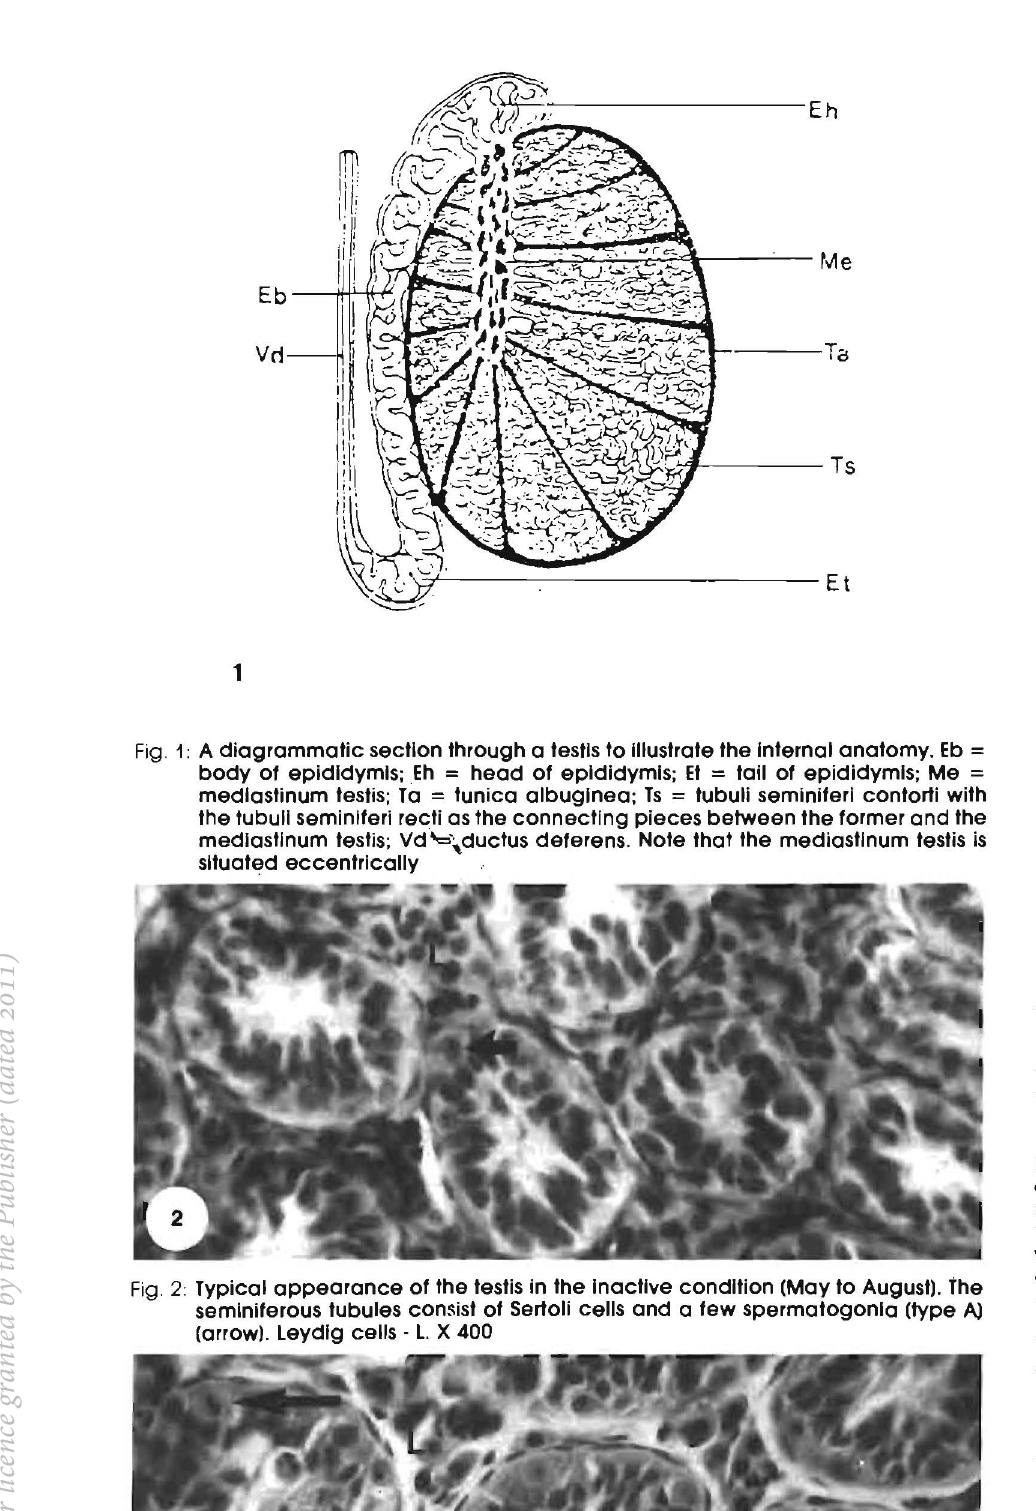
Fig. 2: Typical appearance of the testis in the Inactive condition (May to August). The seminiferous tubules consist of Sertoli cells and a few spermatogonia (type A) (arrow). Leydig cells· L X 400